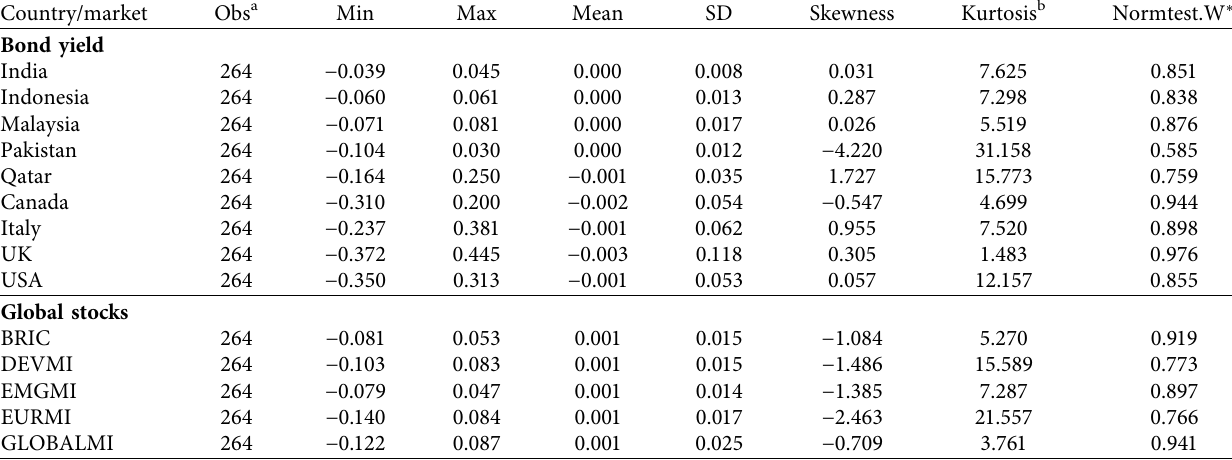
Table 1: Descriptive summary of bond yield and global stock indices